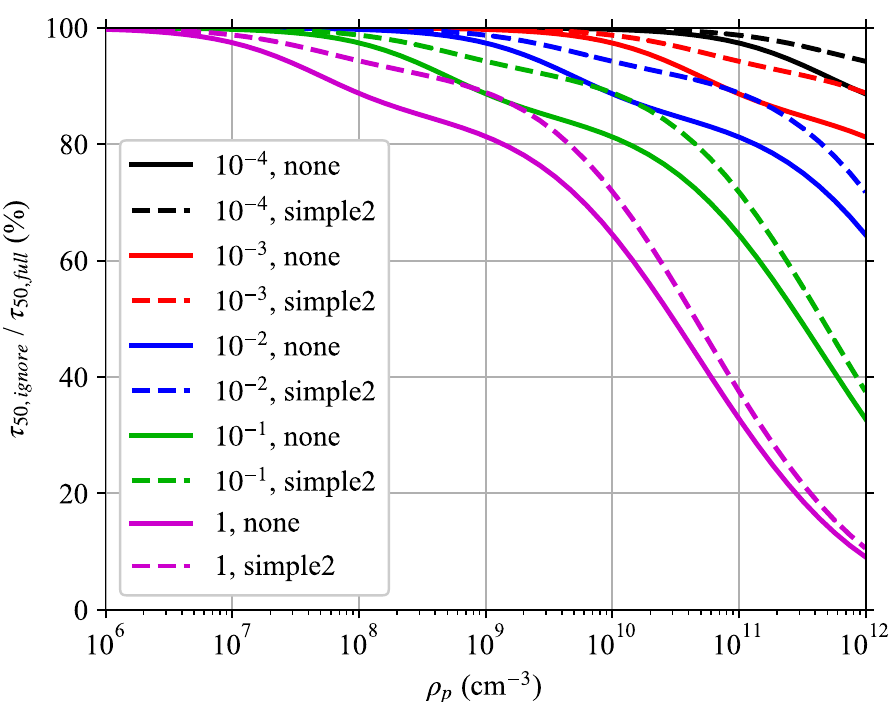
Fig 5. Effect of ignoring multiplicity, full version. Full version of Fig 1 with more ρ and the effect of masks. Plot of p the ratio of the time required to reach a 50% infection risk when multiplicity is ignored τ 50, ignore to when it is fully for different respiratory tract fluid pathogen concentrations ρ . We are considering the same accounted for τ 50, full p situation as in the worked example, but at steady-state with just the speaking mask-less infectious individual and the risk to a susceptible individual whose exposure starts after steady state is reached. The ratio is shown for different combinations of mask on the susceptible individual (none and simple2) and for different r . The legend lists the r , mask combinations in the same order as the lines from top to bottom. We assumed a 100 nm diameter spherical pathogen and used 80 diameter bins and chose the M (maximum multiplicity considered) heuristic threshold to be T = 0.01 c (include 99% of pathogen